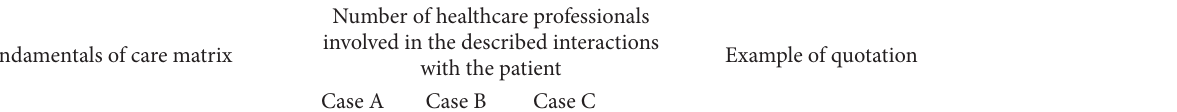
Table 5: The fundamentals of care framework: individual descriptions of care episodes of more negative interactions with staff.